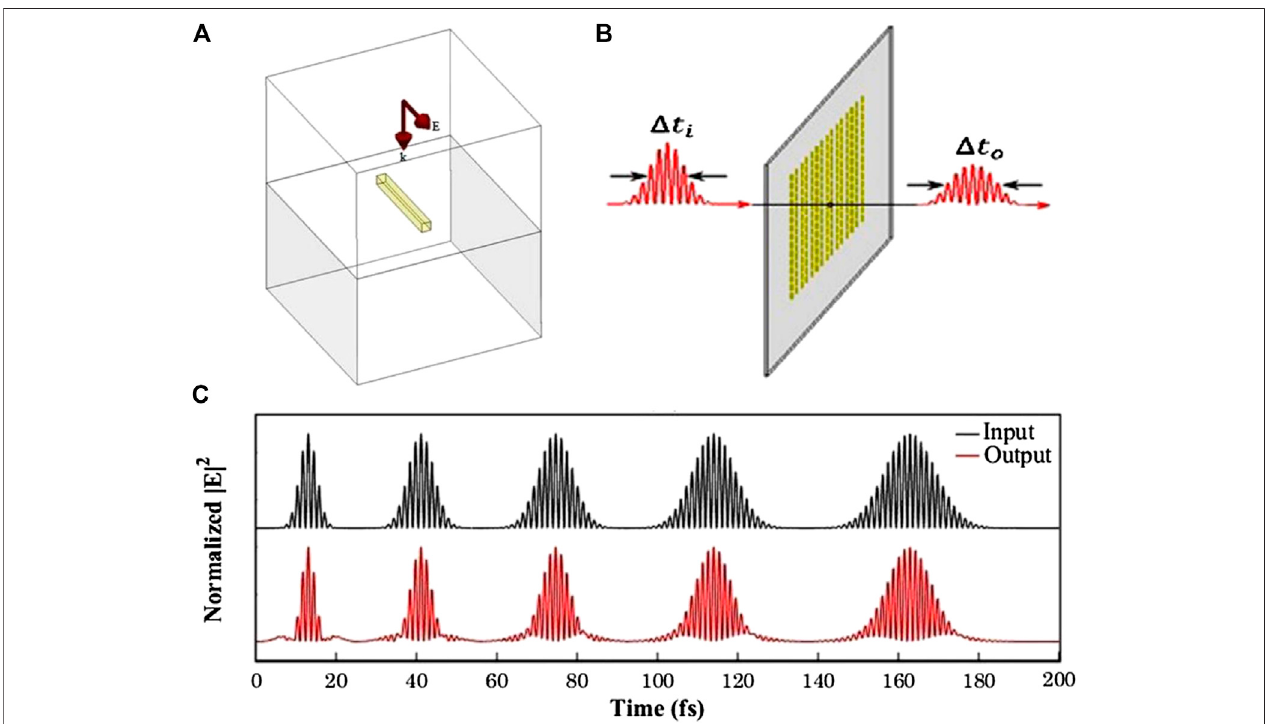
FIGURE 1 | (A) Unit cell of the periodic golden meta-surface on a fused silica substrate with a 2 nm titanium adhesion layer. (B) Pulse shaping schematic using a nano-plasmonic fi lter, which is a periodic golden meta-surface, Δ t i is the half-power pulse width of the input pulse, Δ t o is the half-power pulse width of the output pulse. (C) Input/output comparison for different pulse width at the central frequency of 370 THz. Source : reproduced from Ref. 45.